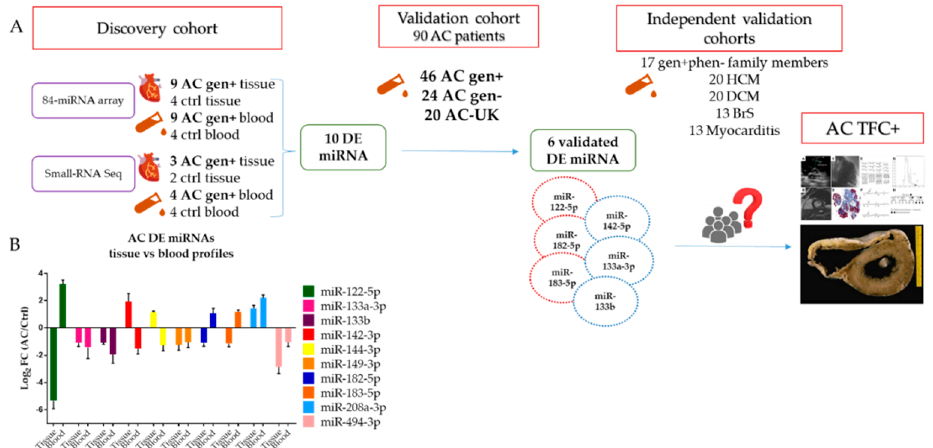
Figure 1. (A ). Flow-chart of the entire cohort analysed, specifying the experimental steps performed; gen+: AC index cases carriers of a rare variant in a desmosomal gene; gen − : AC index cases genotype negative; AC-UK: AC index cases from the University College of London-UCL; gen+phen − : non-affected family members of AC probands carrying a desmosomal pathogenic variant; HCM: hypertrophic cardiomyopathy; DCM: dilated cardiomyopathy; BrS: Brugada syndrome; TFC: Task Force Criteria ( B ). Common tissue and blood profile in the discovery cohort: Log 2 FC mean ± SEM values of the 10 differentially expressed miRNAs.